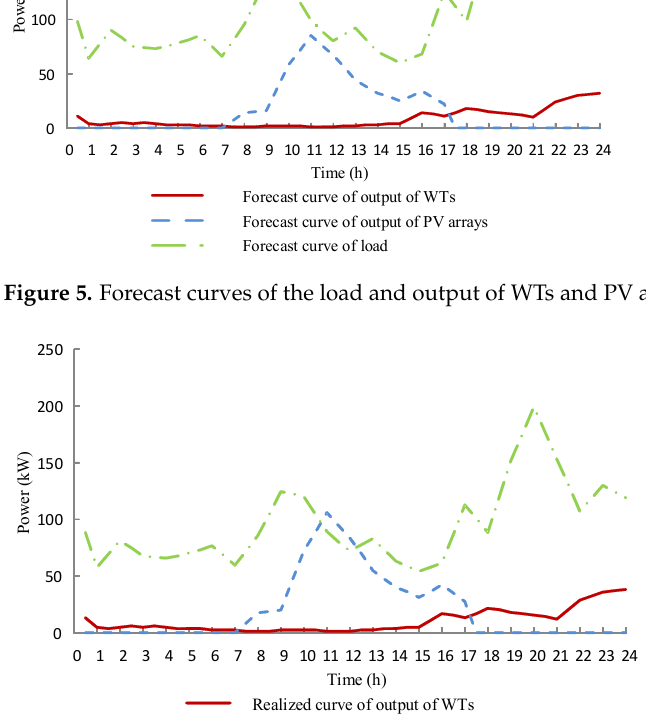
Figure 6. Realized curves of the load and output of WTs and PV arrays.